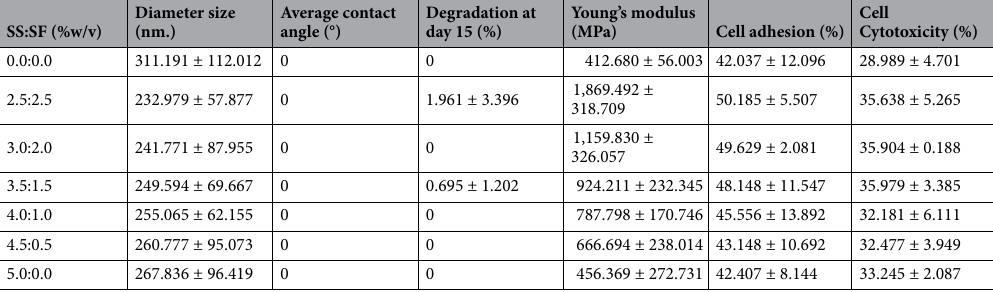
Table 1. Nanofibers characteristics and property with different concentration ratio of SS and